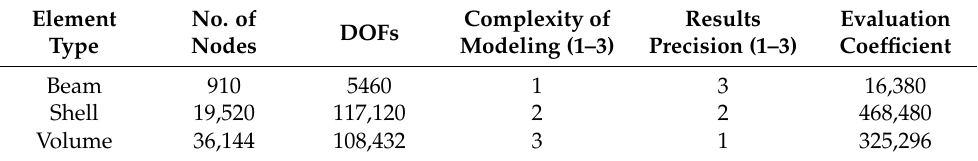
Table 1. Comparative analysis between characteristics of T-junctions modeled with beam, shell, and volume type